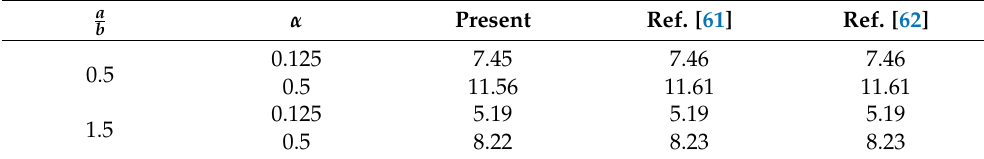
Table 3. Comparison of the non-dimensional critical buckling loads of an elastic plate with variable thickness subjected to uniform uniaxial compressive